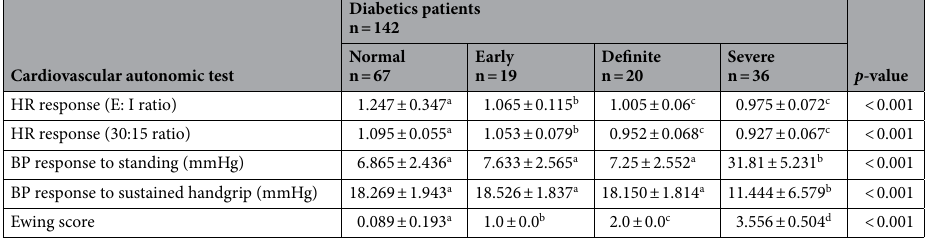
Table 5. Ewing’s tests values of diabetic patients (using ANOVA test). CAN = cardiac autonomic neuropathy; HR = heart rate; E: I = expiration: inspiration; BP = blood pressure, Different small letters indicate significant